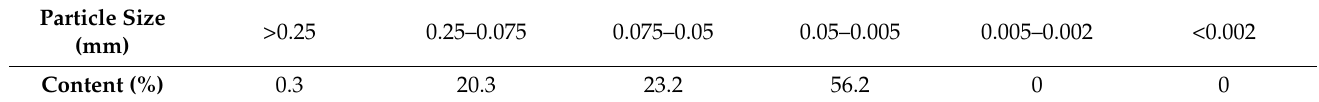
Table 2. The particle size analysis results.